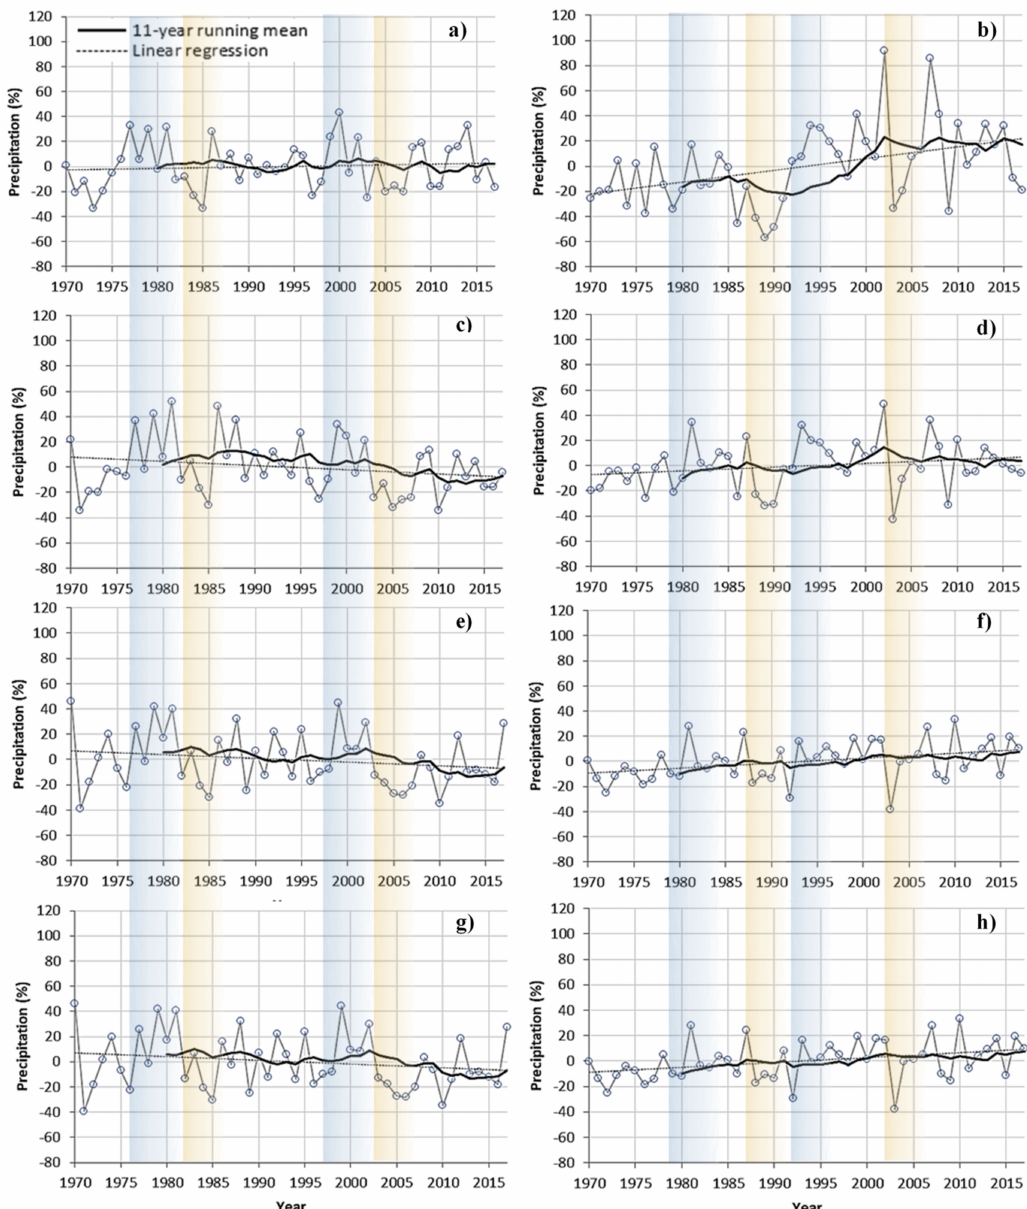
Figure 6. Winter total precipitation anomalies in ( a ) the southern Rhone, ( c ) the northern Rhone, ( e ) Silvretta, ( g ) Clari- den. May–Sept (summer) total precipitation anomalies in ( b ) the southern Rhone, ( d ) the northern Rhone, ( f ) Silvretta, ( h ) Clariden. The blue and red shades show significant